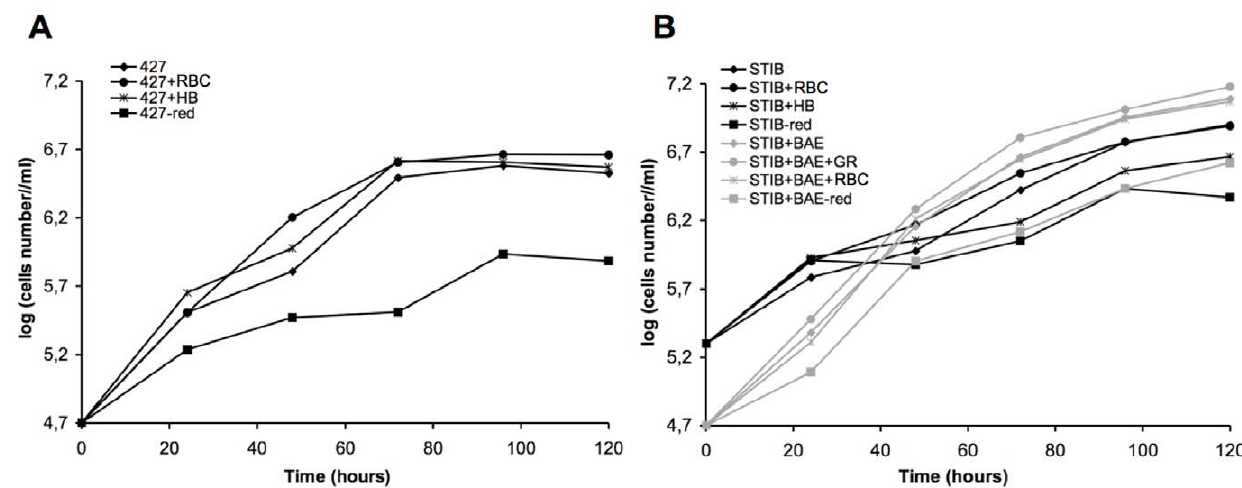
Figure 5. Comparison of T.brucei and T.congolenseinvitro growth. A, T. brucei 427 BSF have been inoculated at 5.10 4 cell/ml in TcBSF-1 (Table 1) medium at 37 u C in a humidified atmosphere containing 5% (vol/vol) CO 2 . B, T. congolense STIB910 BSF have been inoculated at 5.10 4 in presence of BAE (black curves) or at 2.10 5 cell/ml in absence of BAE (grey curves) in TcBSF-2 (Table 1) medium at 34 u C in a humidified atmosphere N containing 5% (vol/vol) CO 2 . Parasites were cultured in their specific medium for five days (—— X ) or in medium supplemented with red blood cell lysate ), or with hemoglobin (100 m g/ml) (— * ), or in absence of (resuspension of red blood cells vol/vol in cold water and 100 fold diluted in medium) (—— reducing agents (Bathocuproin, 2-mercaptoethanol and cystein were removed) (—— & ). Cells were counted every 24